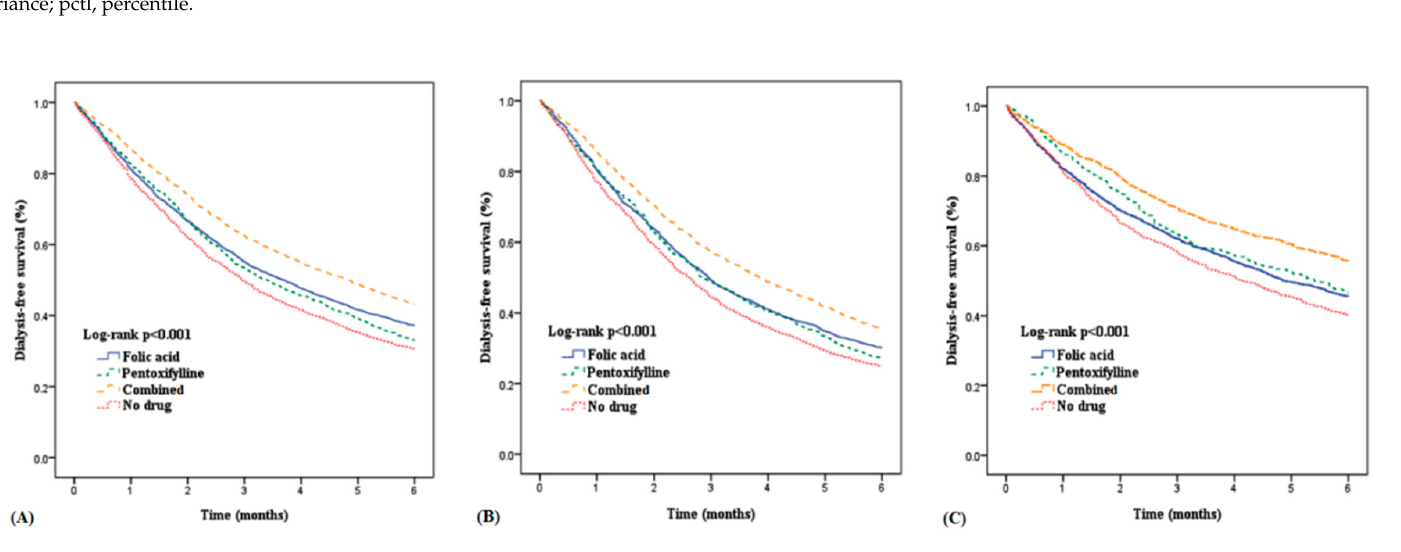
Figure 3. Dialysis-free survival in patients by drug groups among patients with and without diabetes. ( A ) Dialysis-free survival in all patients, ( B ) Dialysis-free survival in patients with diabetes, ( C ) Dialysis-free survival in patients without diabetes.